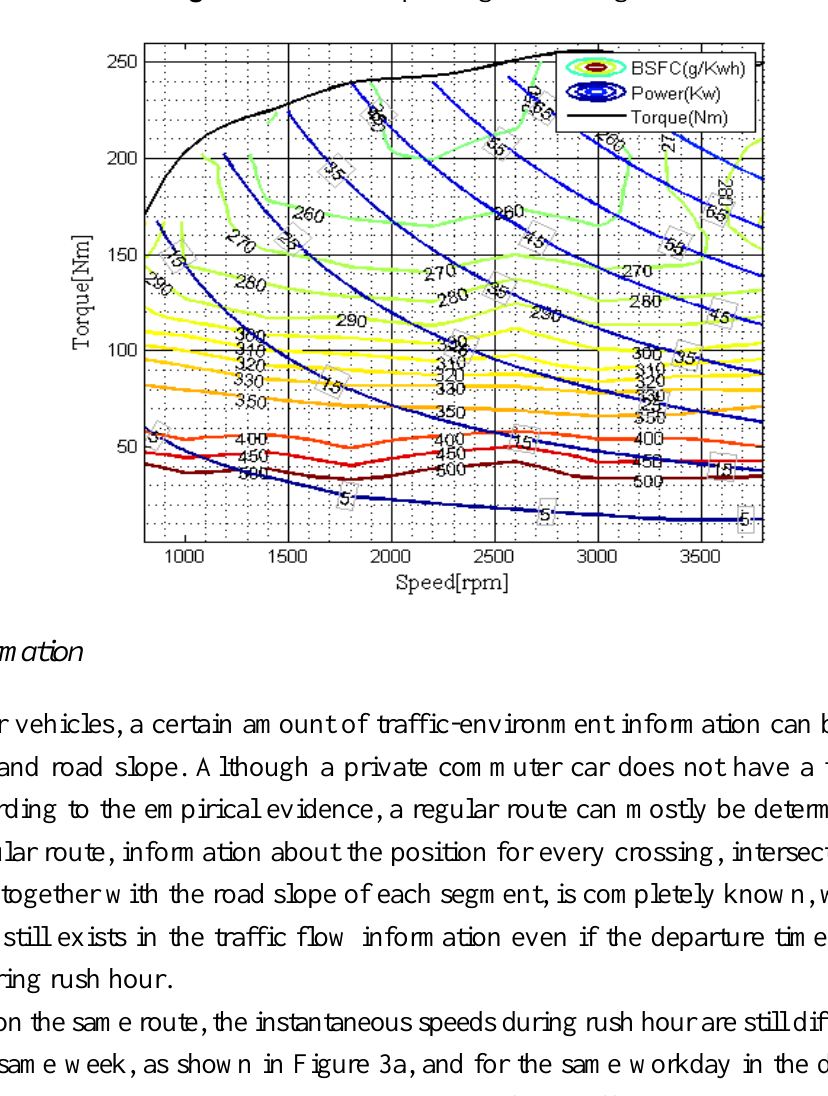
Figure 2. BSFC map of a gasoline